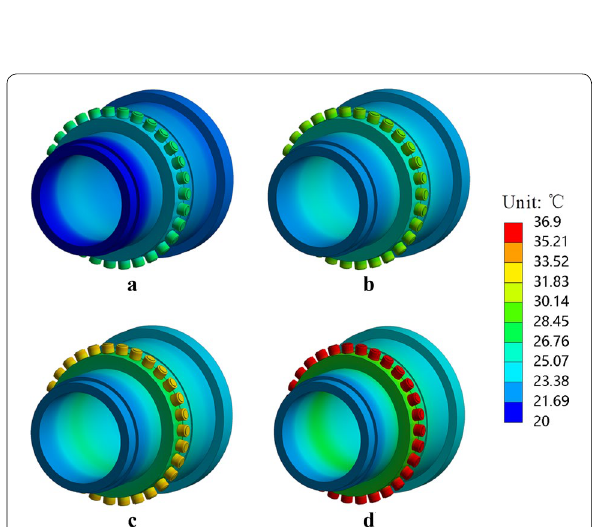
Figure 10 Temperature distribution of worm wheel at different rotating speed: a 300 r/min, b 600 r/min, c 900 r/min, d 1200 r/min